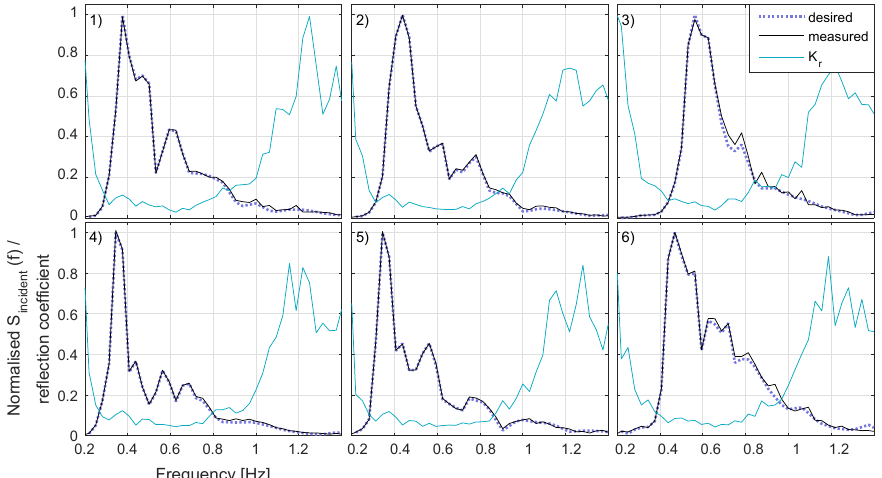
Figure 10. SPAIR incident frequency spectrum outputs for the extreme sea states, compared with desired. Shown with calculated frequency dependent reflection coefficients. 1 ) to 6 ) correspond to sea states 1 to 6 defined in Table